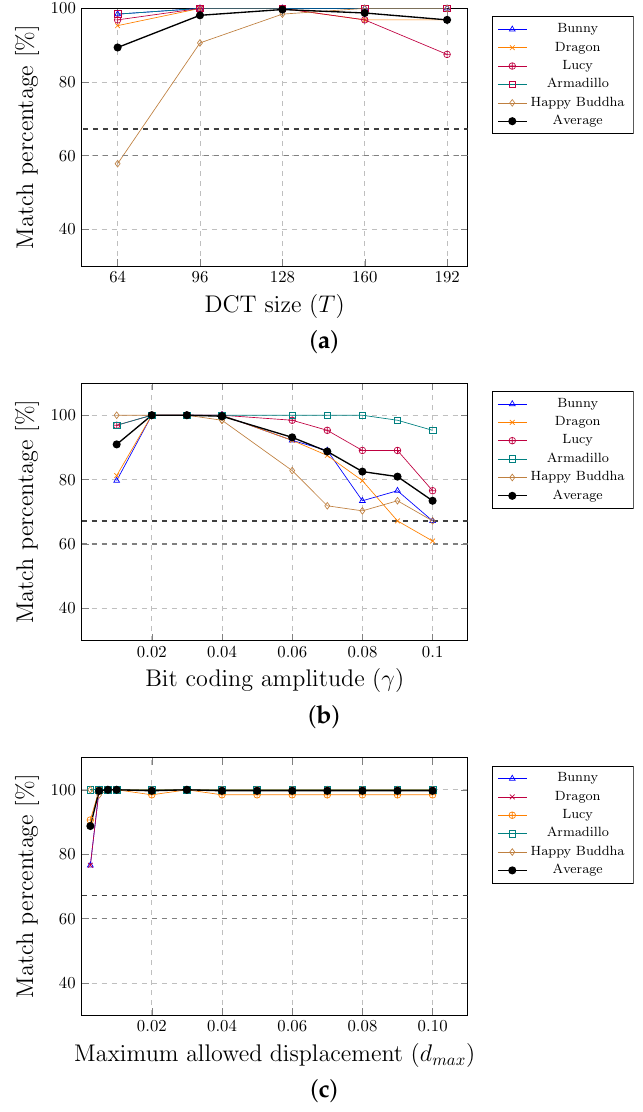
Figure 6. Experimenting with different values of